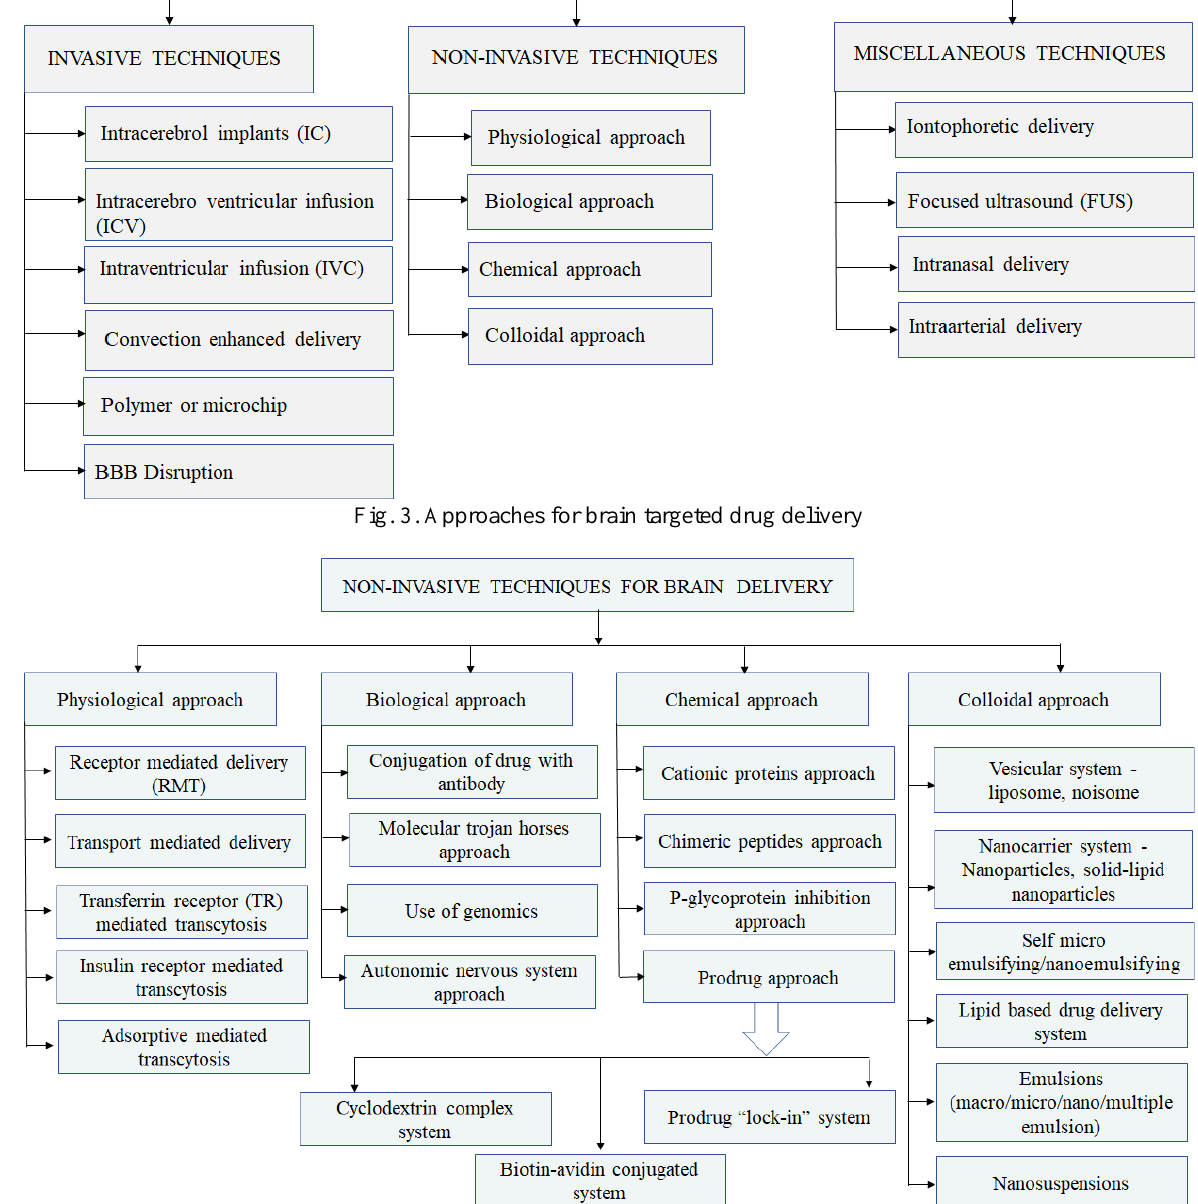
Fig. 4. Non-invasive techniques for brain targeted drug